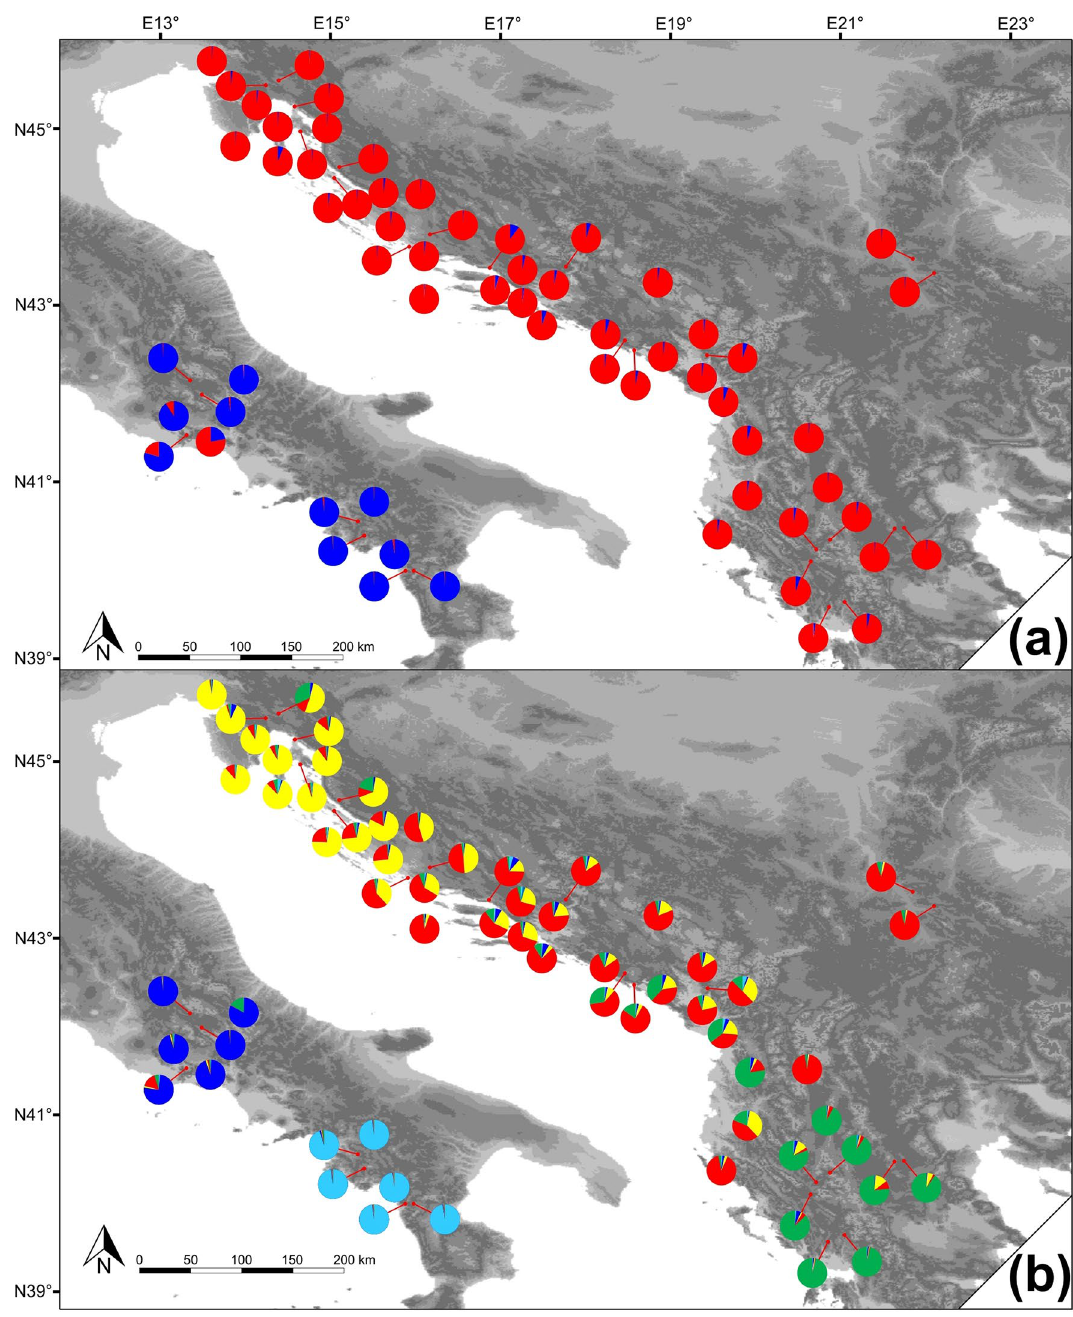
Figure 2. Microsatellite-based genetic structure of common sage ( Salvia officinalis L.) derived from Bayesian model-based clustering analysis using STRU CTU RE. ( a ) Population structure assuming K = 2 and ( b ) K = 5. Each colour represents one genetic cluster: light blue—SAp, dark blue—CAp, yellow—NBalk, red—CBalk, and green—SBalk. The satellite imagery was obtained from Natural Earth public domain map dataset (https:// www. natur alear thdata. com/ downl oads/ 10m- raster- data/ 10m- gray- earth/). CorelDraw Graphics Suite X7 Version 17.1.0.572 (Corel Corp., Ottawa, Canada) was used to create the